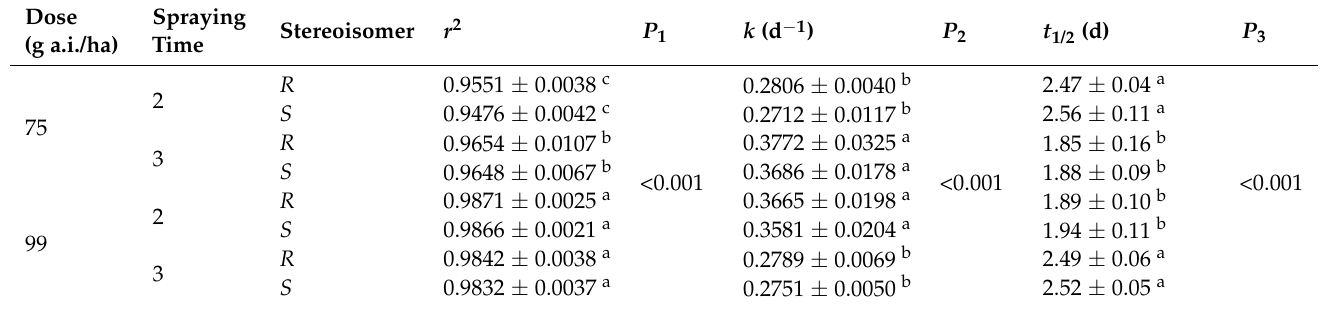
Table 3. Dissipation parameters of two penthiopyrad stereoisomers in field-cultivated eggplants.